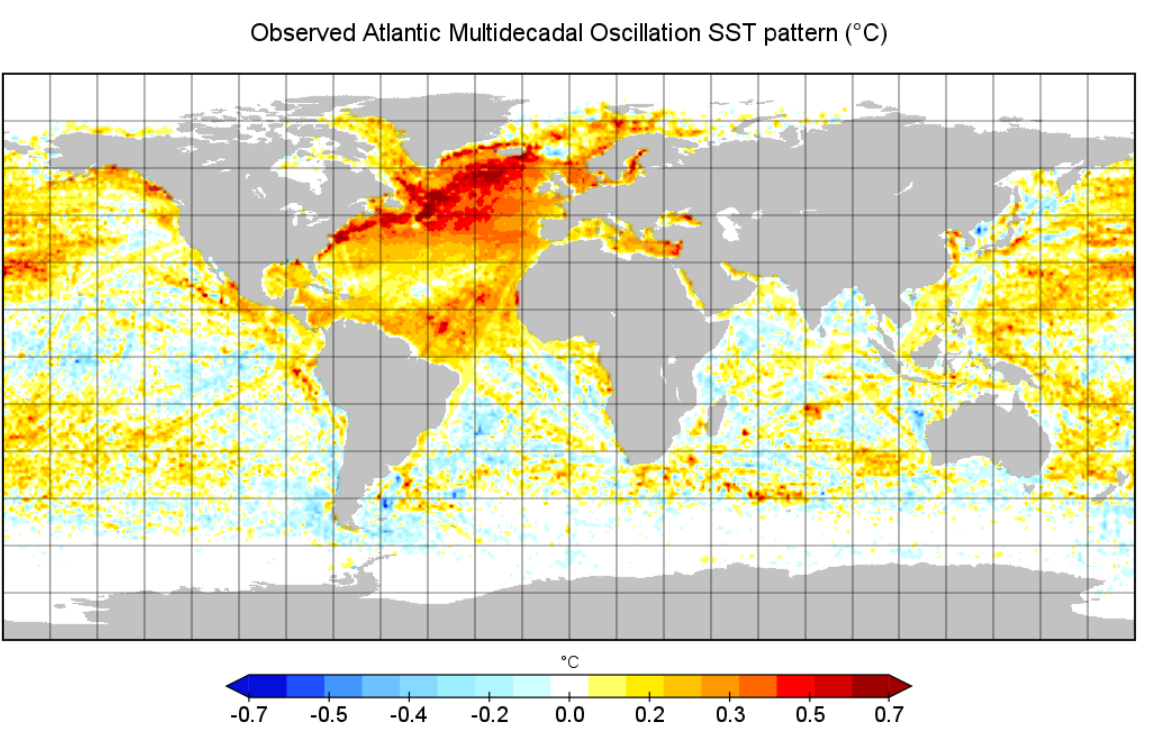
Figure 1. Computed annual sea surface temperature (SST) difference between the warm and cold Atlantic Multidecadal Oscillation (AMO) phases ( ◦ C). Phases are defined based on AMO index (Trenberth and Shea, 2006) using the HadISST dataset for the period